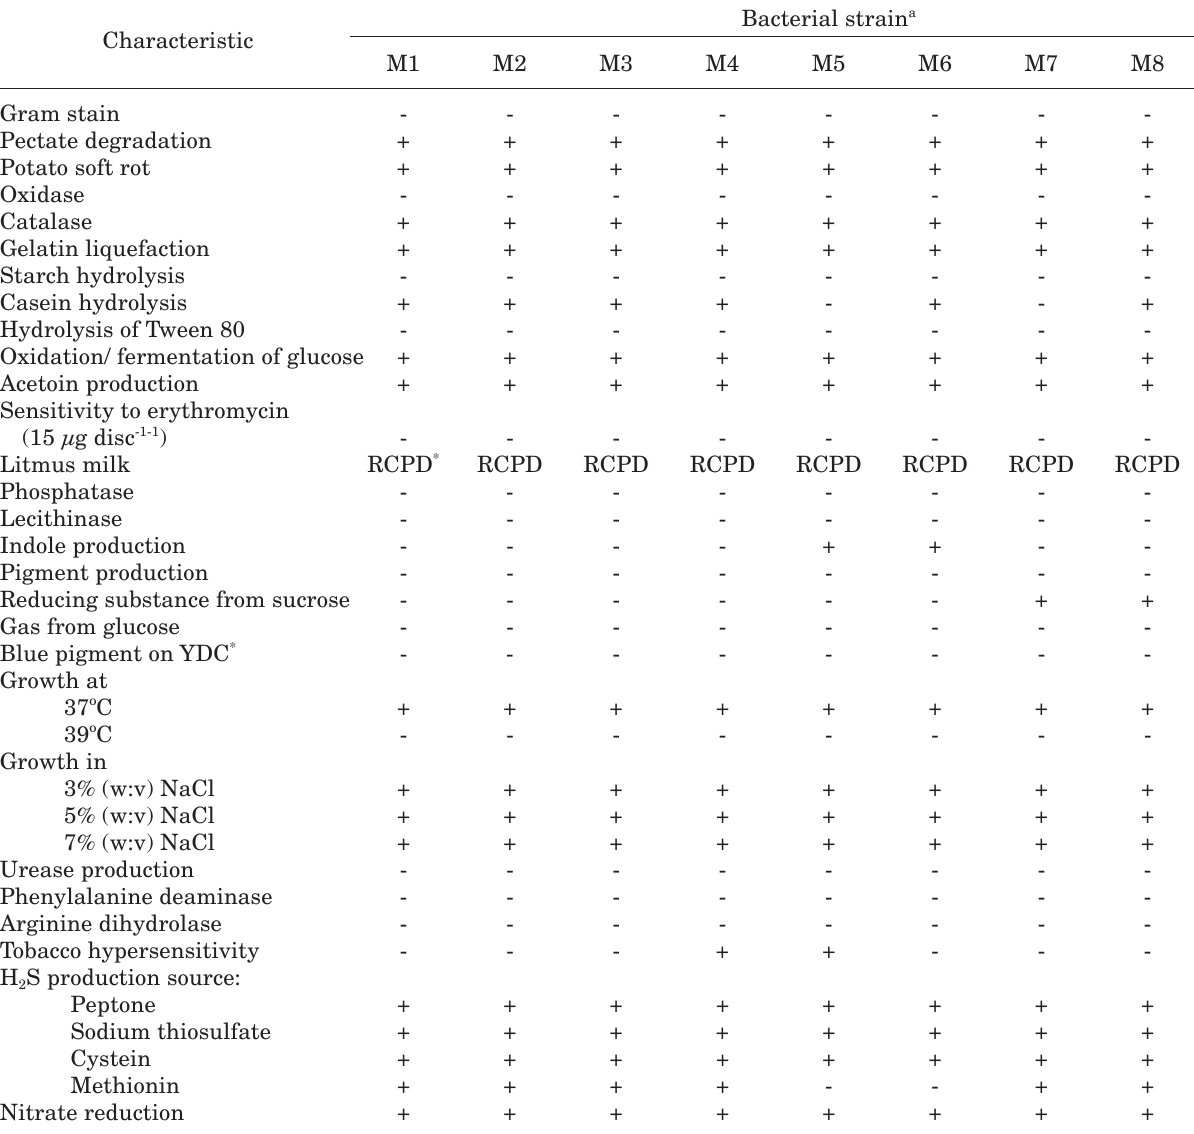
Bacterial strain a